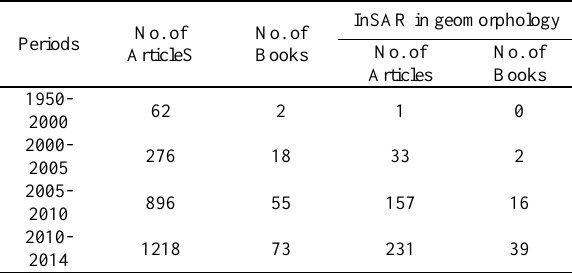
Table 1: the table indicates the number of articles and books about InSAR and with InSAR application. (From Scopus